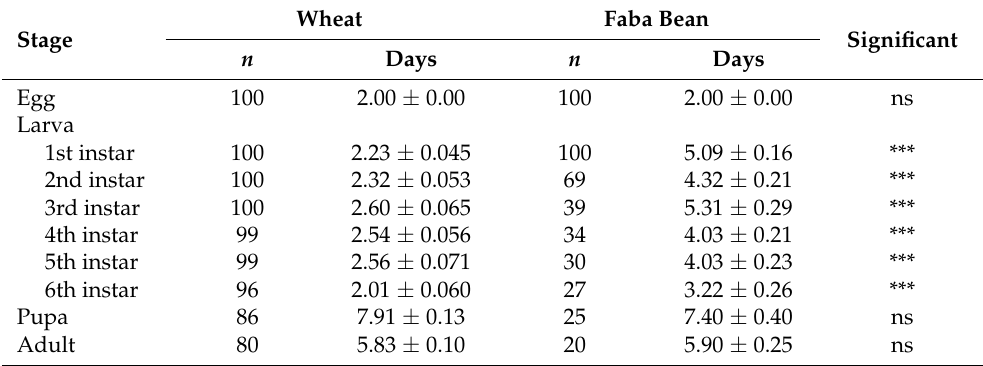
Table 1. The development duration and adult longevity of the S. frugiperda reared on wheat and faba bean